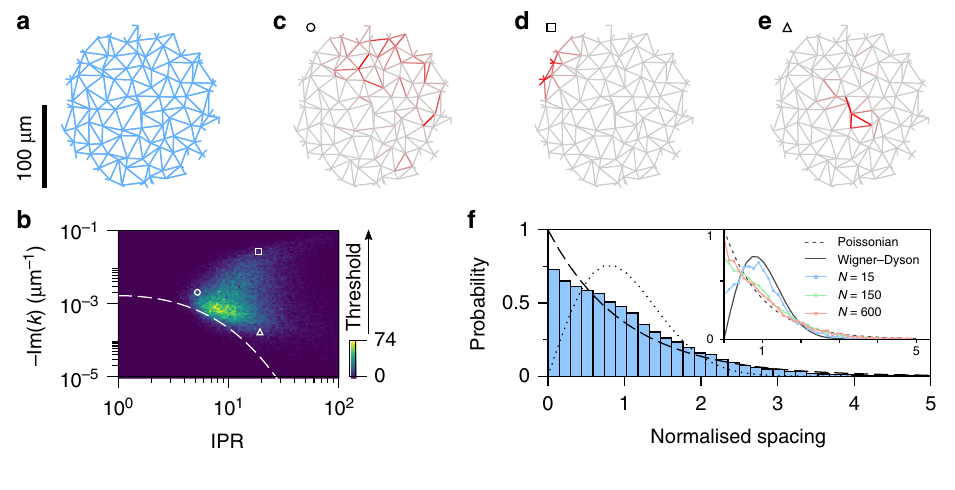
Fig. 3 Properties of the network modes. a For a given network topology (143 nodes, 293 links, average degree D = 6 (excluding nodes at the periphery), average edge length 〈 l e 〉 = 6.5 μ m), the spatial pro fi le and complex k of the optical modes can be computed. b Modes are characterised by the lasing threshold ( − Im( k )) and a degree of localisation described by inverse participation ratio (IPR). The white dashed line is a prediction for modes localised at the centre of the network. c – e The type of mode in different areas of the plot (indicated by the corresponding symbol) is con fi rmed by inspecting their spatial pro fi le (intensity in red): ( c , circle) delocalised modes occupying a signi fi cant system area; ( d , square) lossy modes con fi ned close to the network boundary; ( e , triangle) modes localised in the centre of the system, which are those with the lowest threshold. f The level spacing statistics obtained from the model complex wavevectors' ( k ), for networks with 150 nodes and topology same as in a . The distribution follows mostly an exponential trend with limited mode repulsion. The mode spacing distribution for smaller and larger networks (15 and 600 nodes) is shown for comparison in the